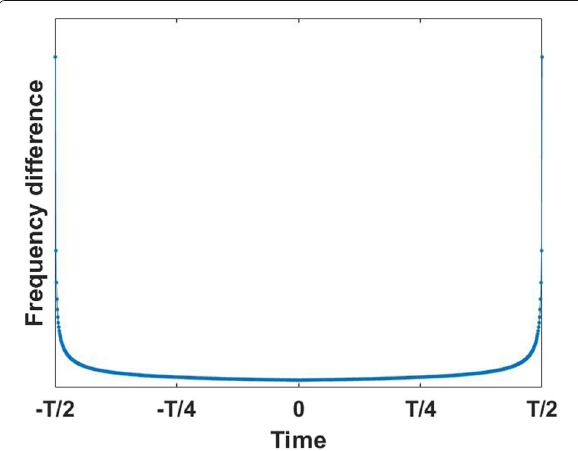
(defined in (7)), but care must be taken during design to make sure that the significant part of the signal energy is contained within the useful bandwidth.